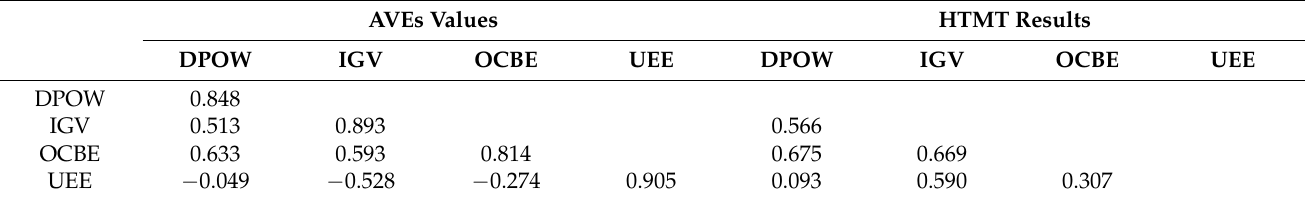
Table 3. Inter-construct correlations, the square root of AVE, and HTMT results.